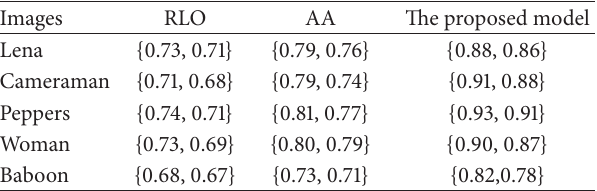
Table 1: Statistical measures { PFOM, SSIM } plotted for different images for different